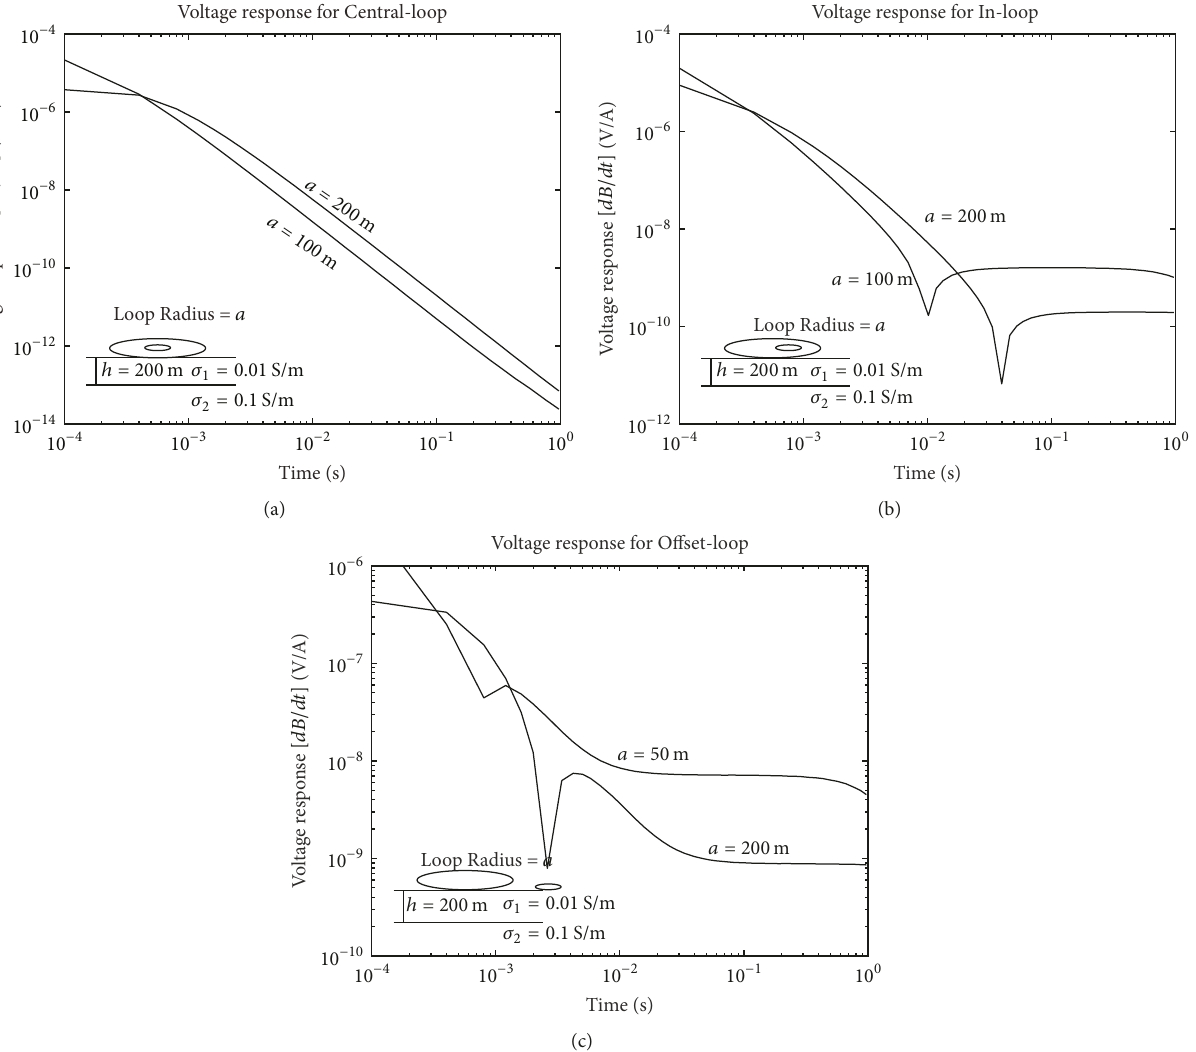
Figure 3: Transient voltage response due to large circular loop source of radii 100m and 200 m over the 2-layer earth model (as shown in the inset of the figure) for (a) central loop configuration, 𝑟 = 0 , (b) arbitrary in-loop configuration, 𝑟 = 𝑎/2 , and (c) arbitrary offset-loop configuration, 𝑟 = 2𝑎